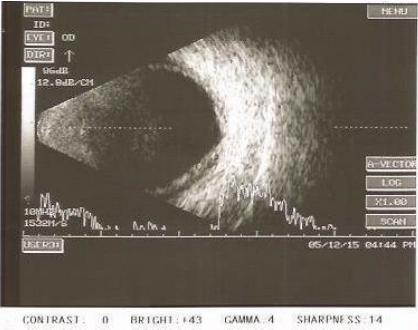
Figure 3: Right eye of the patient in Case Report 2: B-scan ultrasonography shows shallow choroidal detachment.